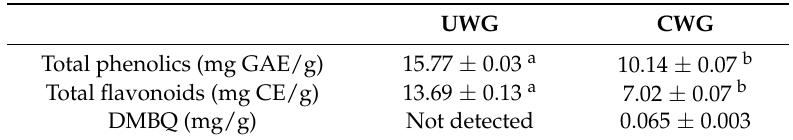
Table 1. Contents of total phenolics and flavonoids and